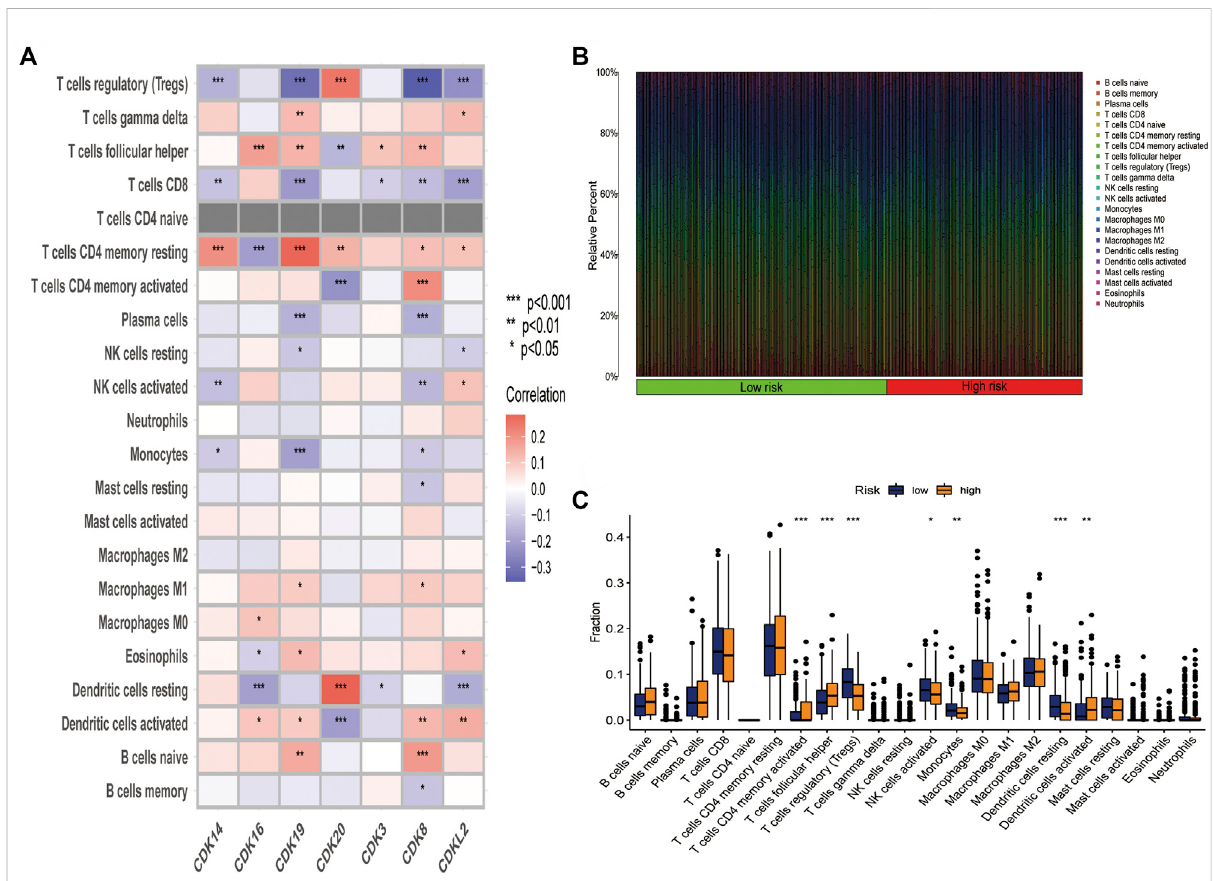
FIGURE 6 The 7 core prognostic genes were signi fi cantly associated with immune cell in fi ltration. (A) Correlation between the 7 prognostic genes and 22typesofin fi ltrationimmunecells. (B) Histogramdemonstratingthedifferenceintheproportionof22typesofminimumcellsinthehigh-andlow- risk groups. (C) Box plots demonstrating the difference in the proportion of 22 types of immune cells in the high- and low risk